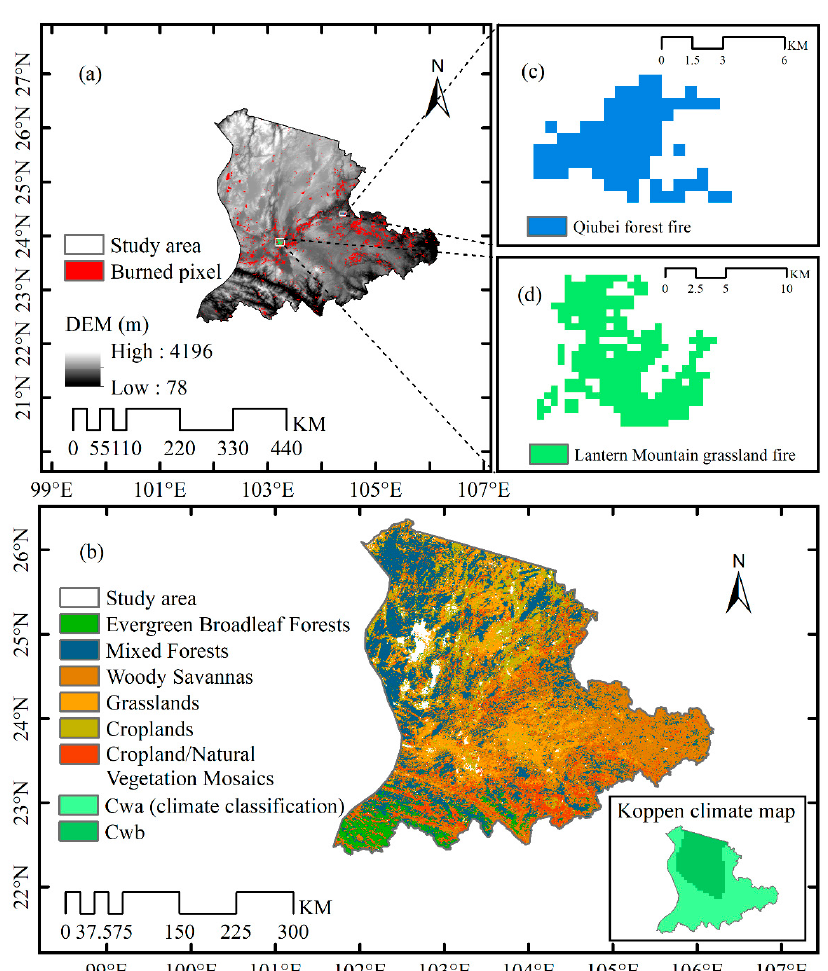
Figure 1. ( a ) Study area showing the historical (2007–2016) burned areas extracted from MCD64A1 Burned Area product and the DEM (Digital Elevation Model) as the background image. ( b ) Dominated vegetation types and Koppen climate classification. The location and burned pixels of ( c ) the Qiubei forest fire event on the 1st February 2010, and ( d ) Lantern Mountain grassland fire event on the 13th February 2016. Cwa: Subtropical Highland Zone; Cwb: Humid Subtropical Zone.